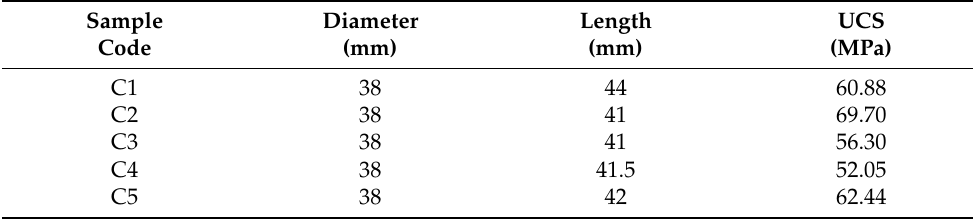
Table 2. UCS values obtained for the five dry samples.